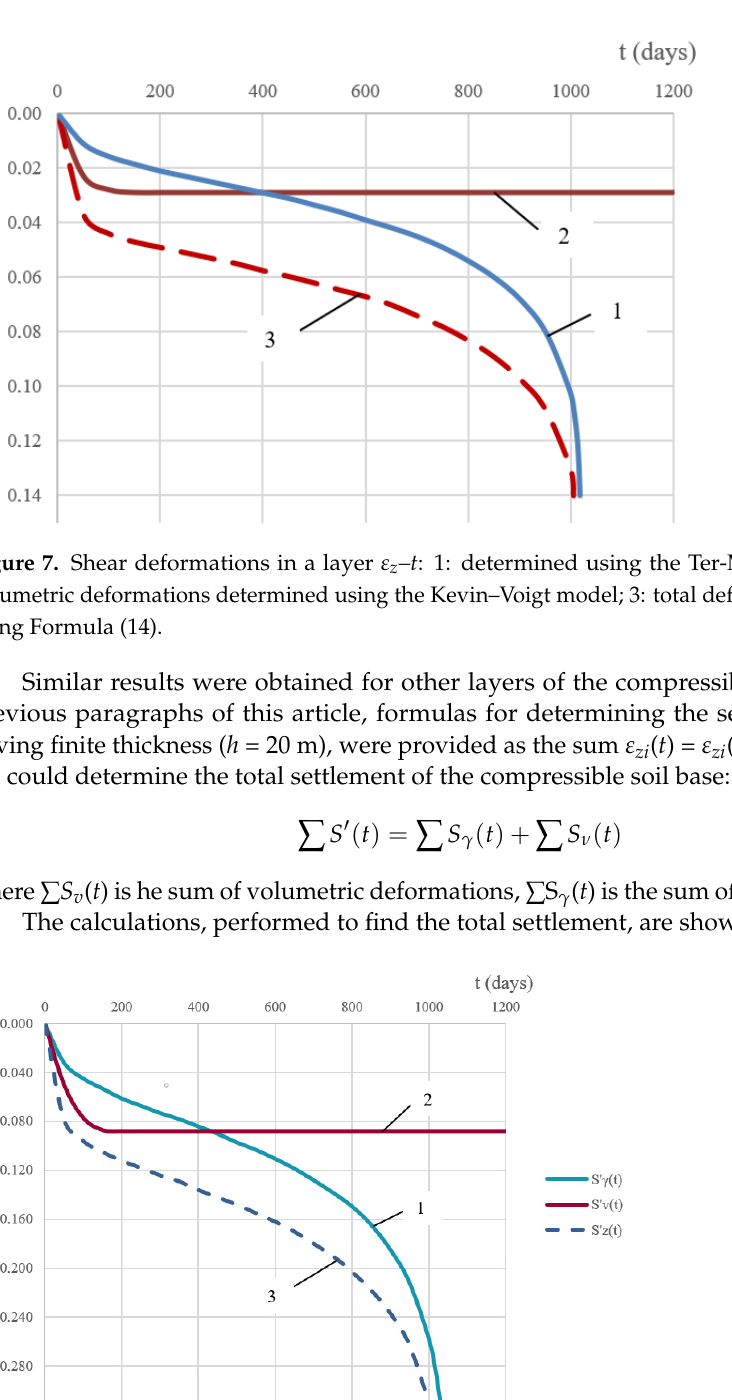
8 of 12 Figure 6. Results of analytical and numerical calculations of stress components at q = 200 kPa , c = 6 m , b = 2a = 6 m . Isolines of vertical stresses σ z obtained using MathCAD software package ( a ); isolines of mean stresses σ m obtained using MathCAD software package ( b ); isolines of vertical stresses σ z obtained using PLAXIS 2D software package ( c ); isolines of mean stresses σ m obtained using PLAXIS 2D software package ( d ); the calculation pattern applied to determine shear and volumetric deformations of the soil basis based on the physical equations derived by H. Hencky, including σ zp , σ zg , σ zm epures ( e ). A calculation in the PS PLAXIS was carried out to verify the isolines of vertical and mean stresses obtained earlier by analytical calculation using Formulas (1)–(3). We used the model Linear Elastic in PS PLAXIS, with the parameters E = 25,000 kPa, ν = 0.37, γ = 0 kN/m 3 . The following parameters (see Table 1) were used to obtain the curves describing the creep of compressed soil base layers over time (Formula (15)): Table 1. Soil base parameters.